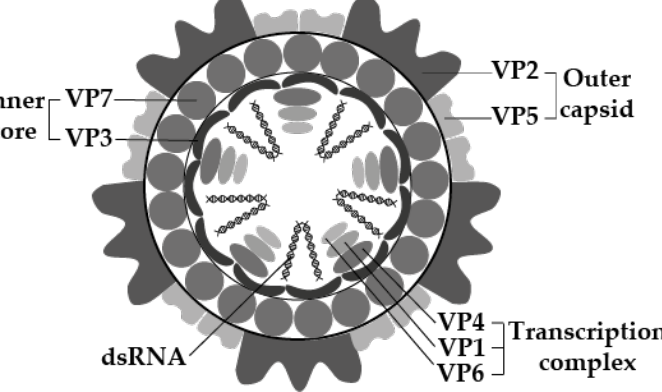
Figure 1. The molecular structure of EEV, according to electron microscopy and molecular studies of EEV, and closely related Orbiviruses . Visualization was based on the work of [13,16] and created using Adobe Illustrator 25.4.1© (Adobe Inc., Mountain View, CA, USA).